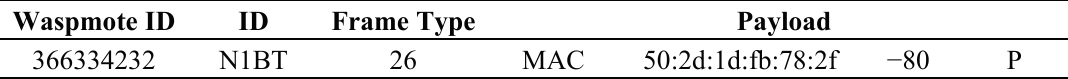
Table 1. UIS BT node